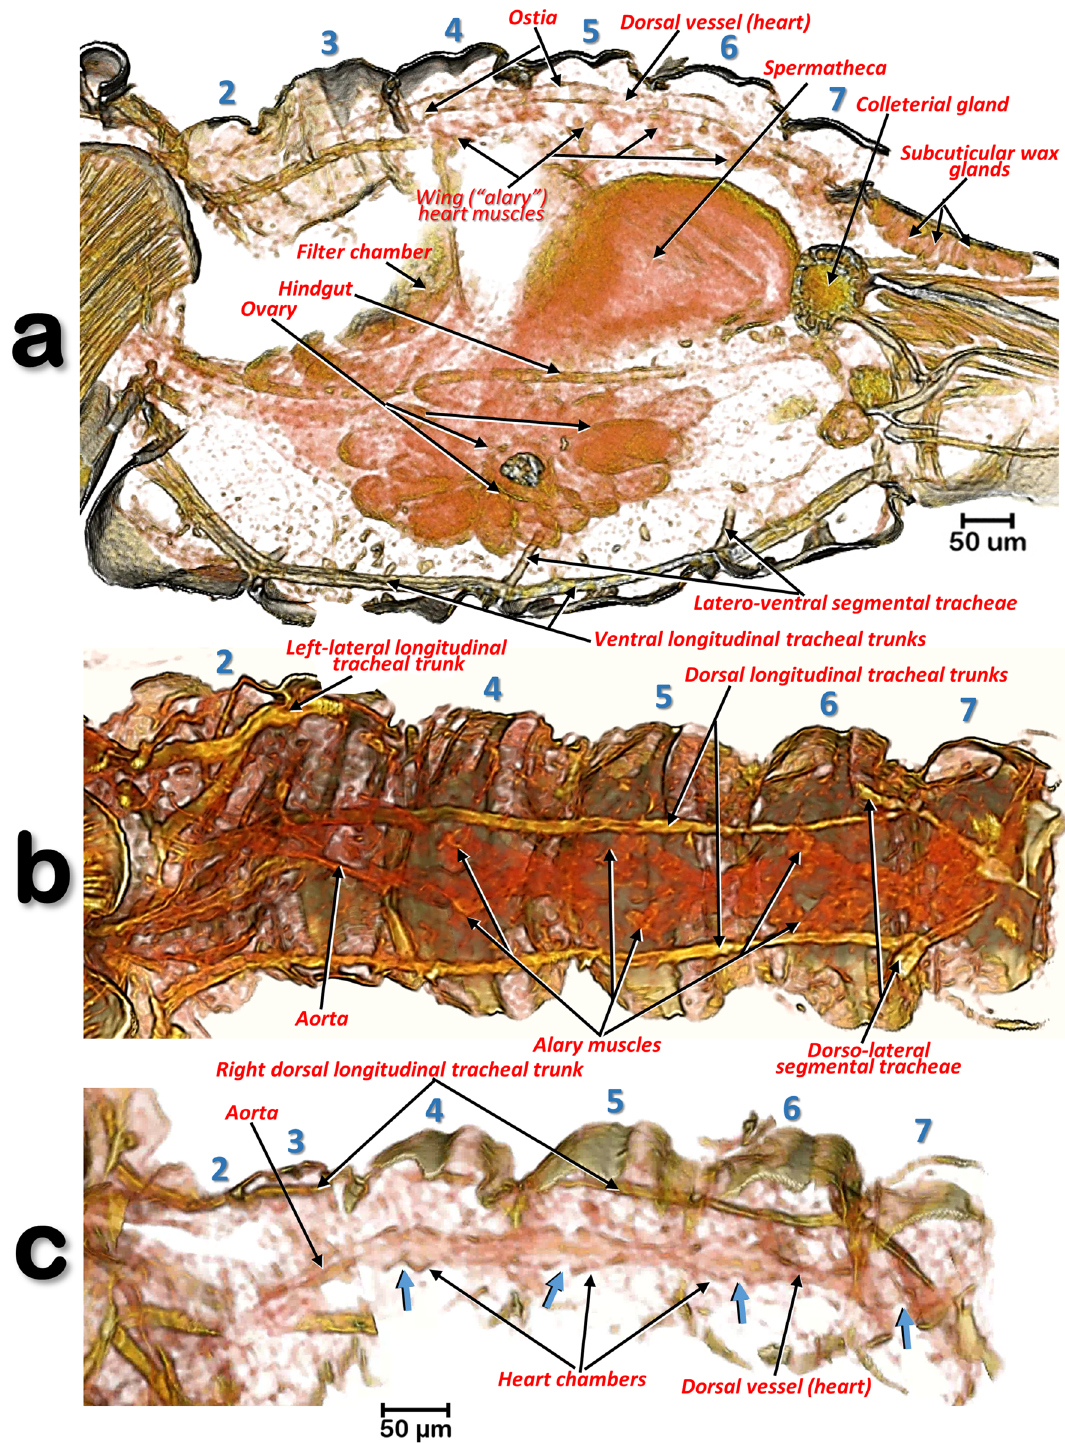
Figure 10. Volume-rendered images of different slice cuts of the abdomen of a female Diaphorina citri . Abdominal oblique sagittal slice, at the level of the dorsal vessel and left ventral tracheal trunk ( a ). Internal view of the dorsal abdominal region ( b ). External view of the dorsal vessel (tergites have been virtually removed by software) ( c ). In ( c ) the blue arrows indicate the ostia of the heart chambers. Abdominal segments are numbered